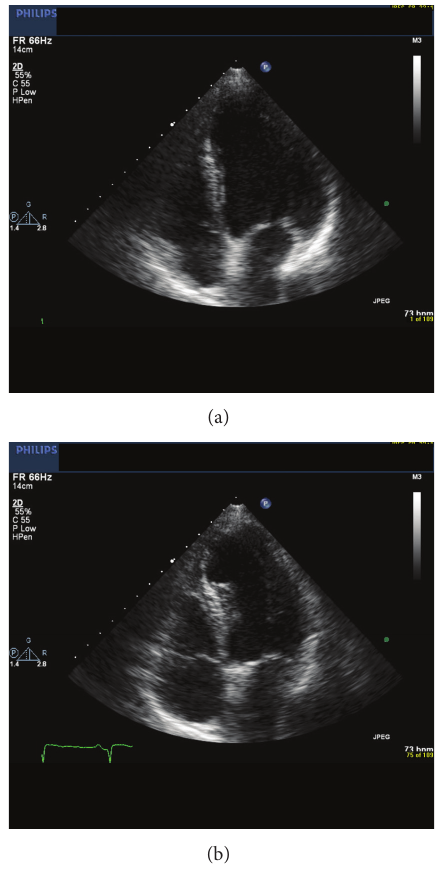
Figure 2: Two-dimensional echocardiographic view demonstrating new anterior wall motion abnormality (apical 4-chamber view) at diastole (a) and systole